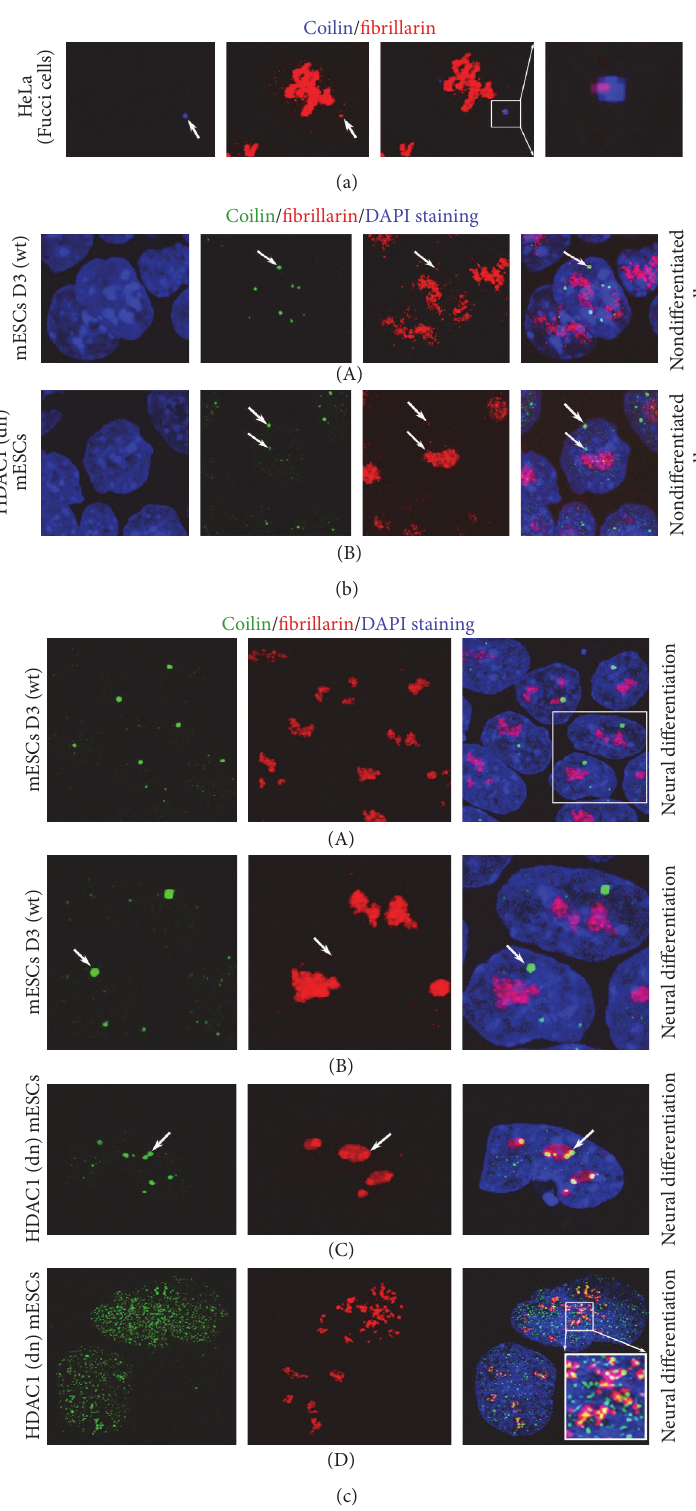
Figure 5: The spatial link between coilin and fibrillarin in HeLa cells and mouse pluripotent mESCs before and after neural differentiation. Arrows show fibrillarin and coilin occurrence in CBs in (a) HeLa cells; CB (blue) colocalizes with fibrillarin foci (red) (white arrows). (b) In (A) wt and (B) HDAC1 dn pluripotent ESCs, CBs (green) were located in a close proximity to the periphery of the fibrillarin-positive regions of the nucleoli (red). An example of CBs is shown by arrows. (c) The spatial link between CBs (green) and fibrillarin (red) in (A, B) wt mESCs and (C, D) HDAC1 dn mESCs undergoing neural differentiation (white arrows). Accumulated coilin (green) inside the nucleoli (red) was observed in HDAC1 dn cells (see (C) and (D)). DAPI staining (blue) was used to visualize the cell